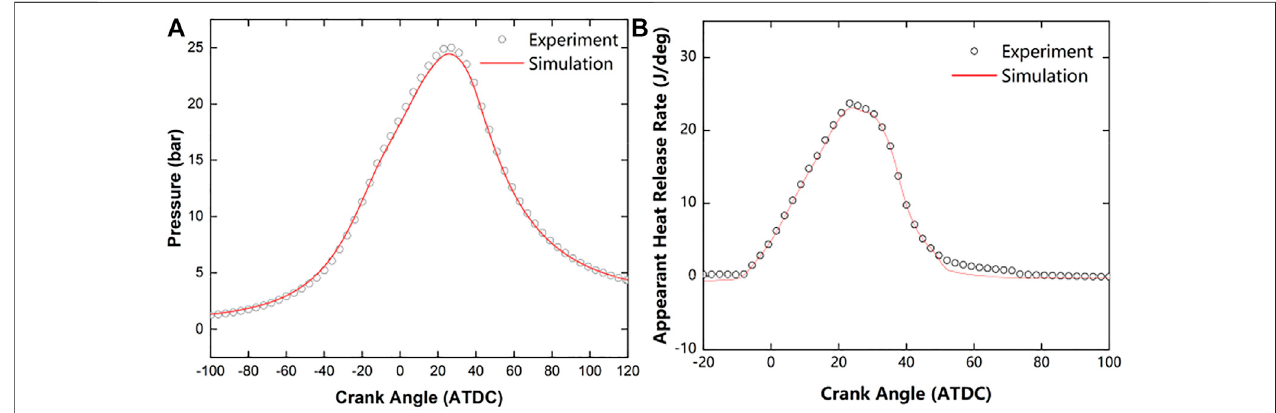
FIGURE 2 | The comparison of simulated data with measured data at the 300 CAD BTDC injection timing: (A) pressure trace and (B) apparent heat release rate curve.